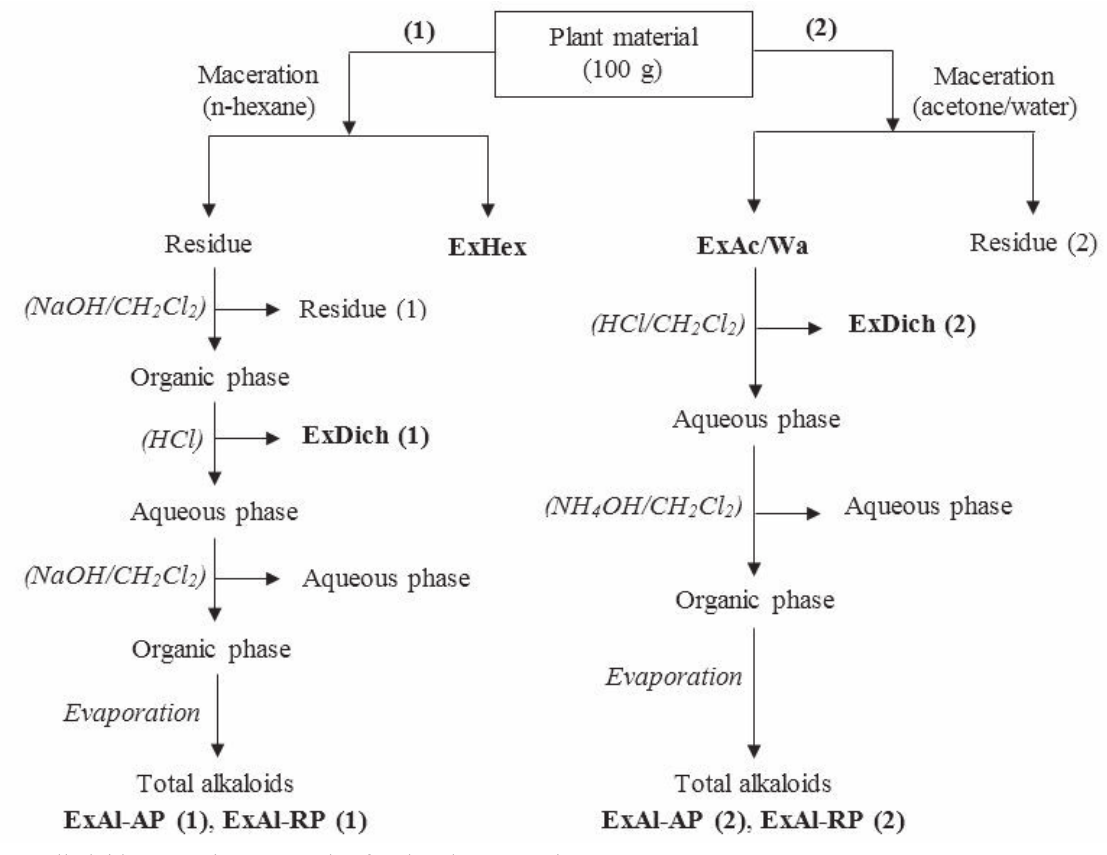
FIGURE 1 - Alkaloids extraction protocols of Haloxylon scoparium. (1): First extraction protocol; (2): Second extraction protocol; ExHex: Hexane Extract; ExAc/Wa: Water Acetone Extract; ExDich: Dichloromethane Extract; ExAl-AP: Extract of Alkaloids from Aerial Part; ExAl-RP: Extract of Alkaloids from Root